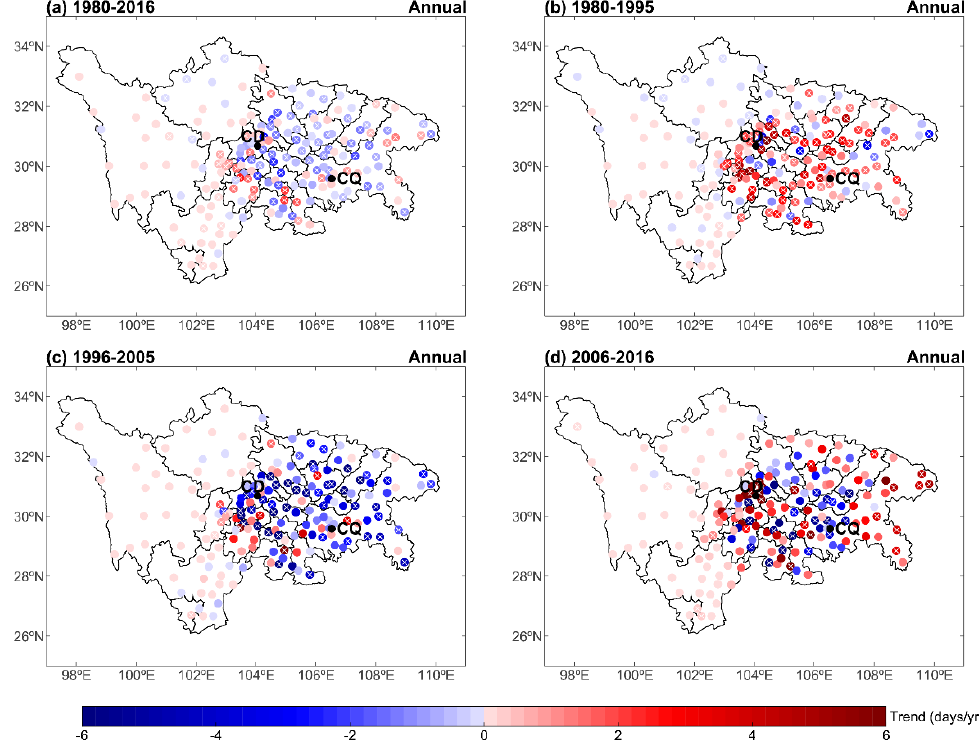
Figure 7. Linear trend of station annual HDs for the four periods: ( a ) 1980–2016; ( b ) 1980–1995; ( c ) 1996–2005; and ( d ) 2006–2016. The circle with a cross means trend above 95% significance level.